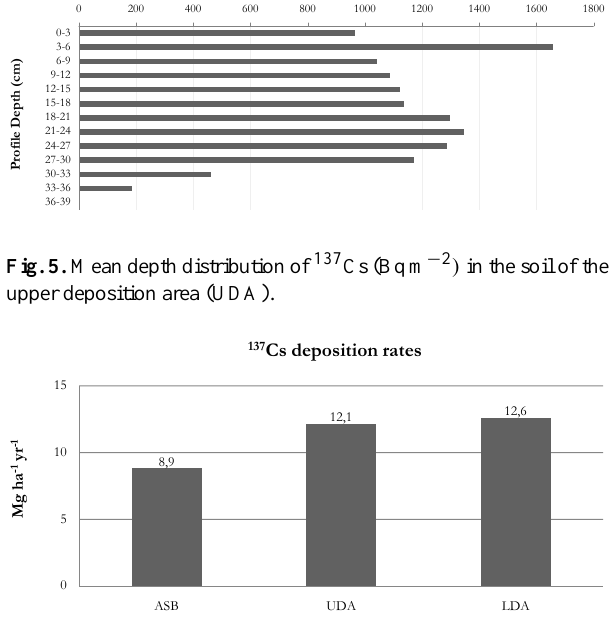
Fig. 4. Mean depth distribution of 137 Cs (Bqkg − 1 ) in the soil of the area Above Snow Bridge (ASB).